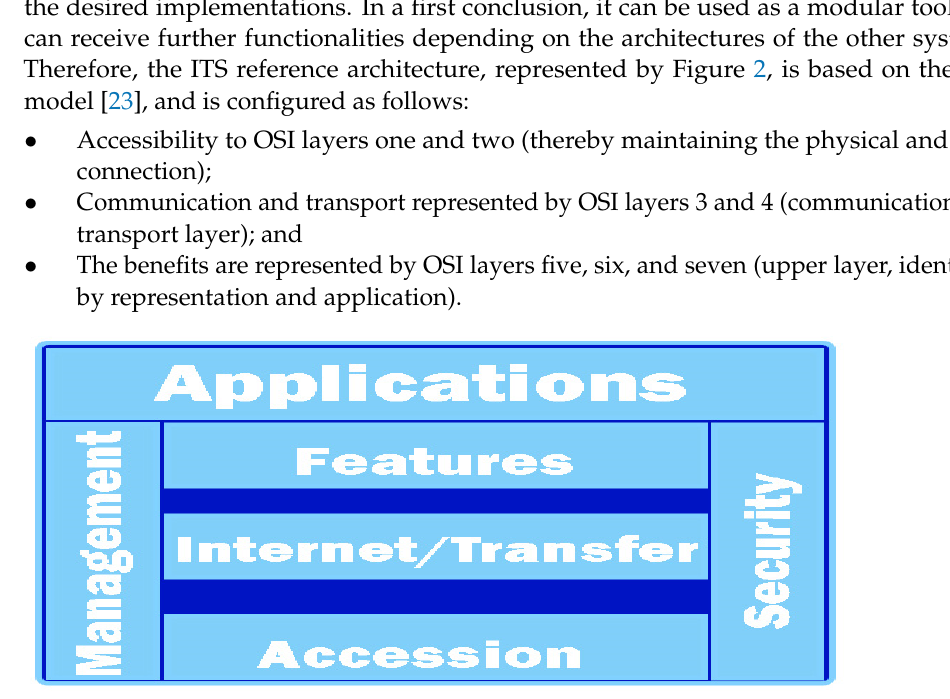
Figure 2. ITS reference architecture—ISO/OSI model.